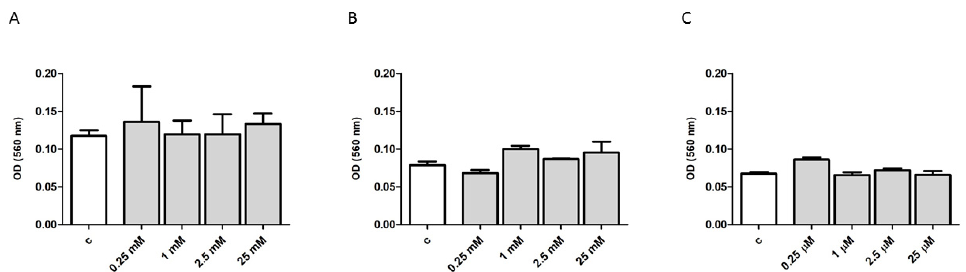
Figure 5. Sildenafil does not exert any effect onto the cell viability of human skeletal muscle cells (Hfsmc), normal and SSc fibroblasts. A , B and C depict cell viability in Hfsmc, healthy and SSc human dermal fibroblasts, respectively, as evaluated with an MTT test after 24h treatment with 0.25; 1; 2.5; 25 μ M of sildenafil. Results are reported as change in absorbance at 560 nm. Results are derived from three different experiments, using distinct cell preparations.